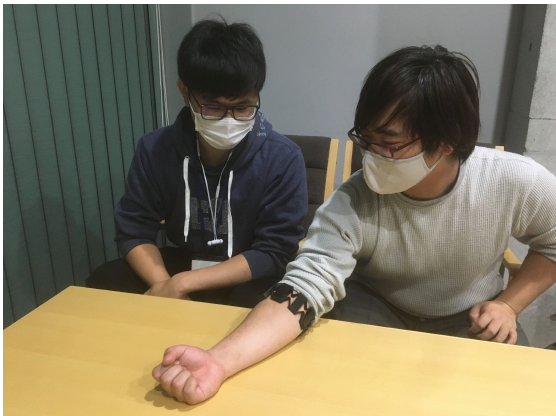
Figure 3. Genuine user showing their rhythmic gesture to the impostor visually for mimicking.